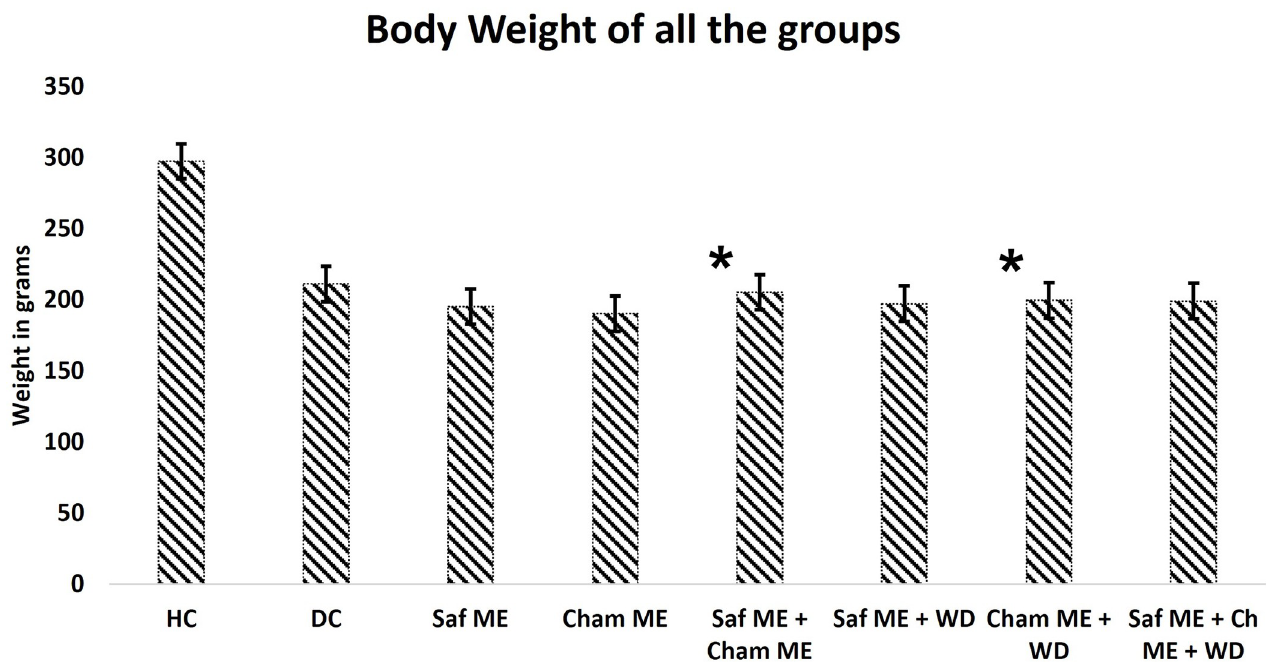
Fig 2. Body weight of all the groups. Healthy Control (HC), Diseased Control (DC), Saffron (Saf) ME, Chamomile (Cham) ME, Saf ME + Cham ME, Saf ME + Water Decoction (WD), Cham ME + WD, Saf ME + Cham ME + WD. � shows significant difference (p < 0.01) from DC.